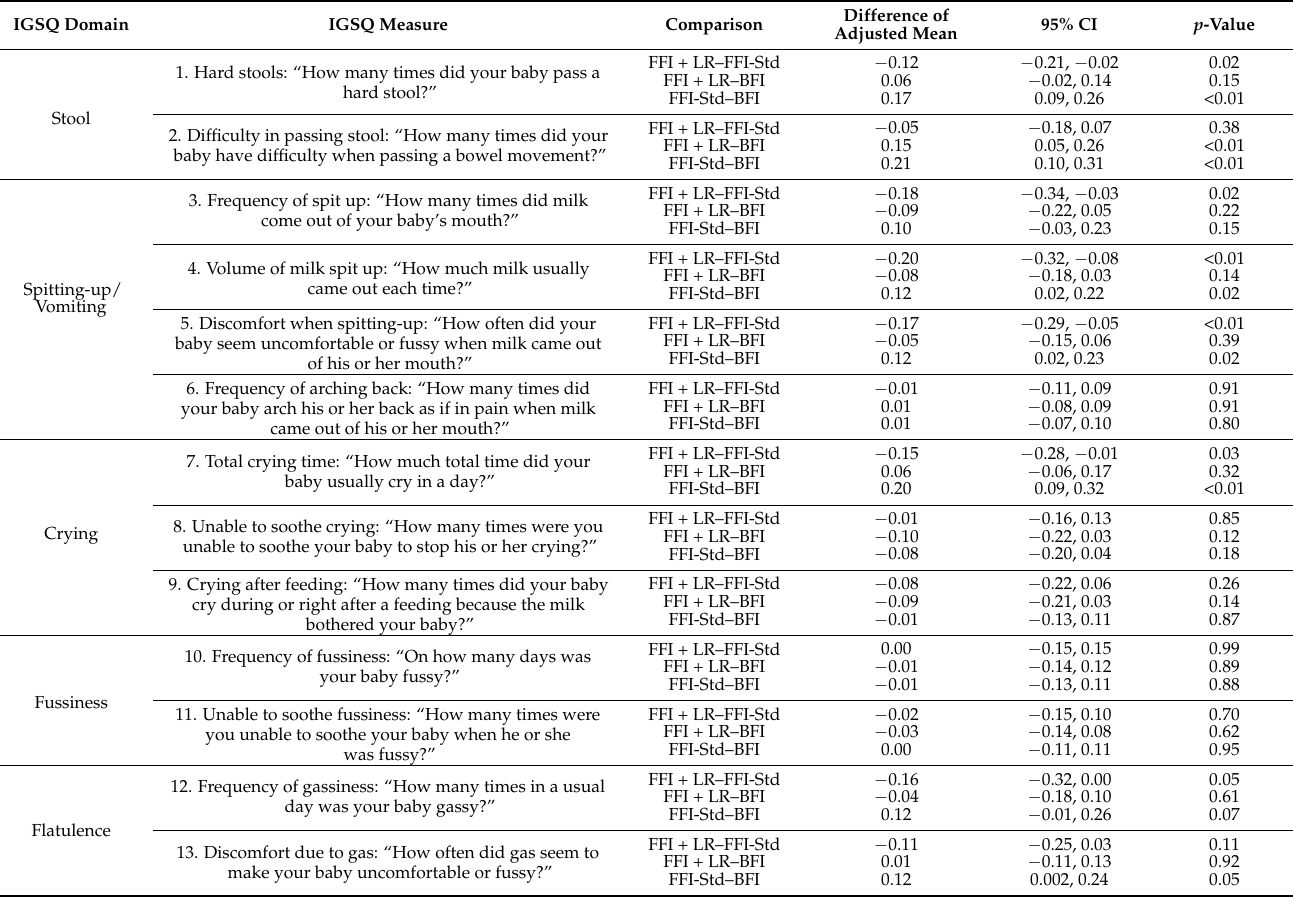
Table 2. Adjusted mean difference in individual IGSQ item scores between feeding groups 1